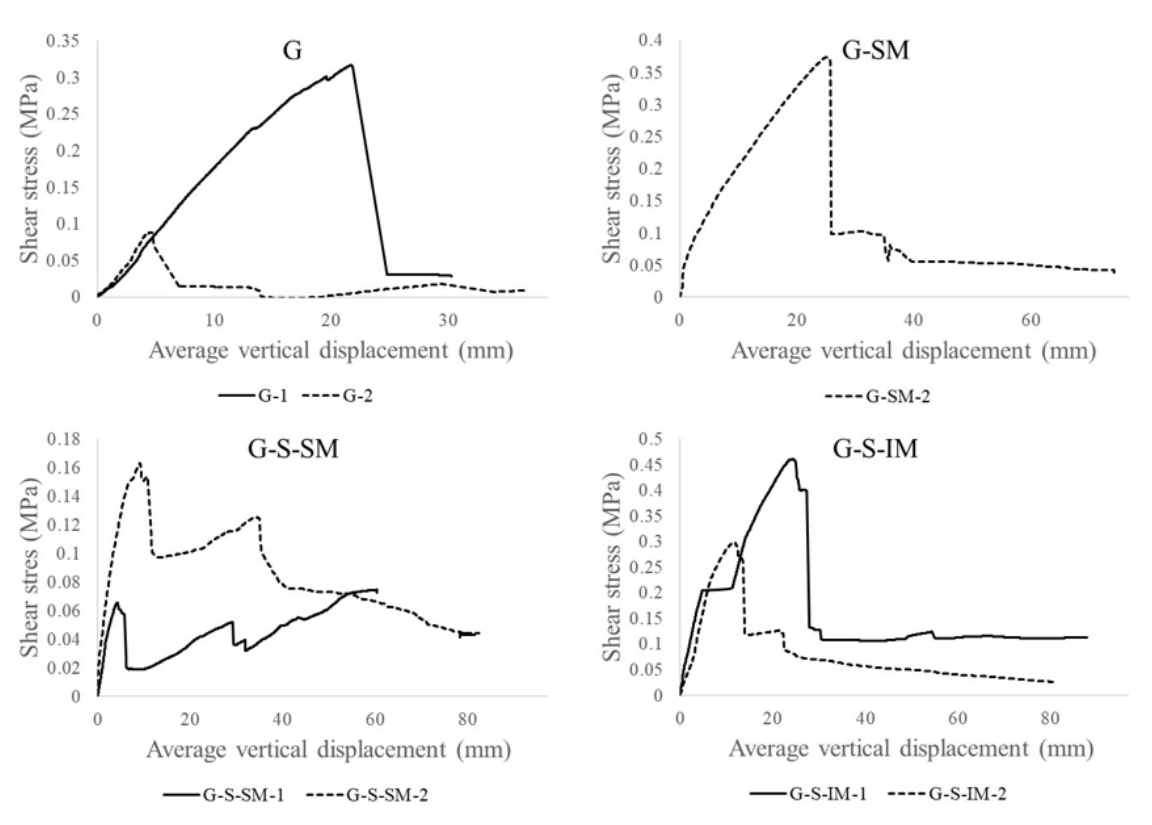
Figure 9. Shear stress-average vertical displacement plots.